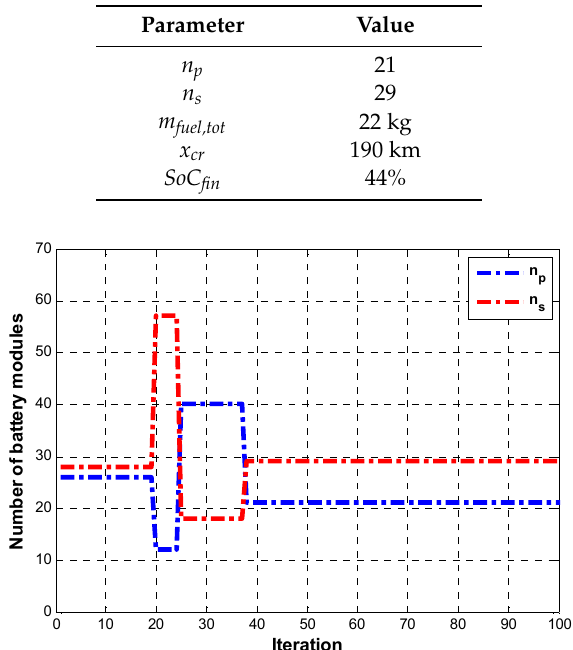
Figure 6. Variation of solutions for the number of modules in optimization Problem 1.